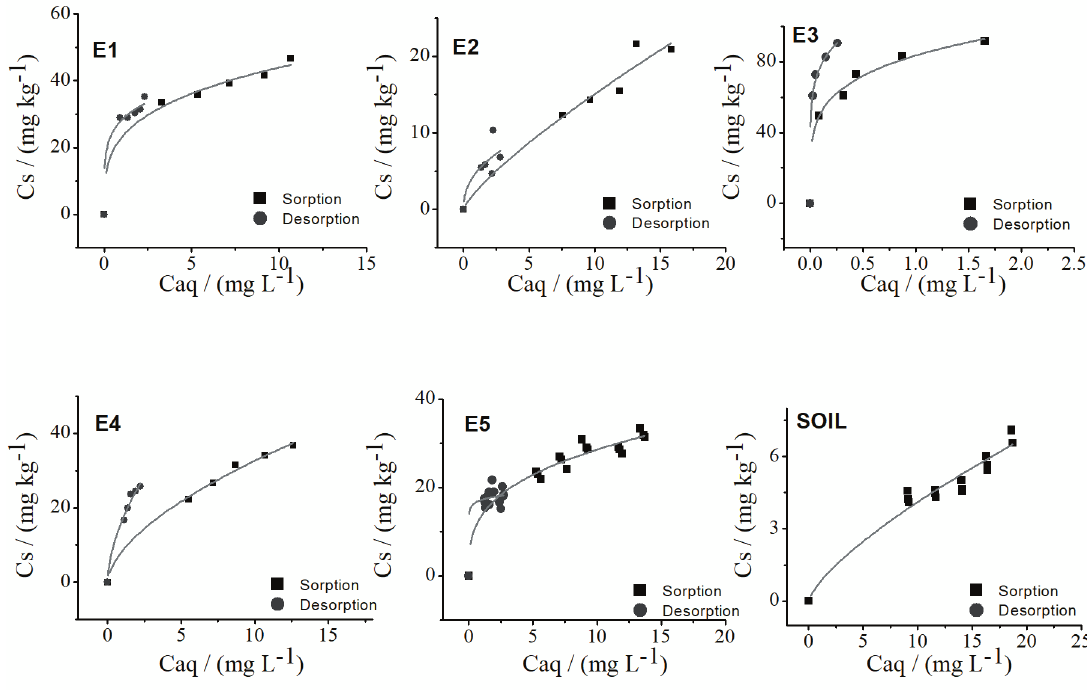
Figure 4 - Isotherms obtained in the CMZ sorption and desorption assays in a Red Latosol amended with different particle sizes and percentages of biochar (E1: soil amended with 0.25% of biochar in particle size < 106 µm; E2: soil amended with 0.25% of biochar in particle size between 508-610 µm; E3: soil amended with 1% of biochar in particle size < 106 µm; E4: soil amended with 1% of biochar in particle size between 508-610 µm and E5: soil amended with 0.5% of biochar in particle size between 106-508 µm) and without addition of the sorbent (SOIL).